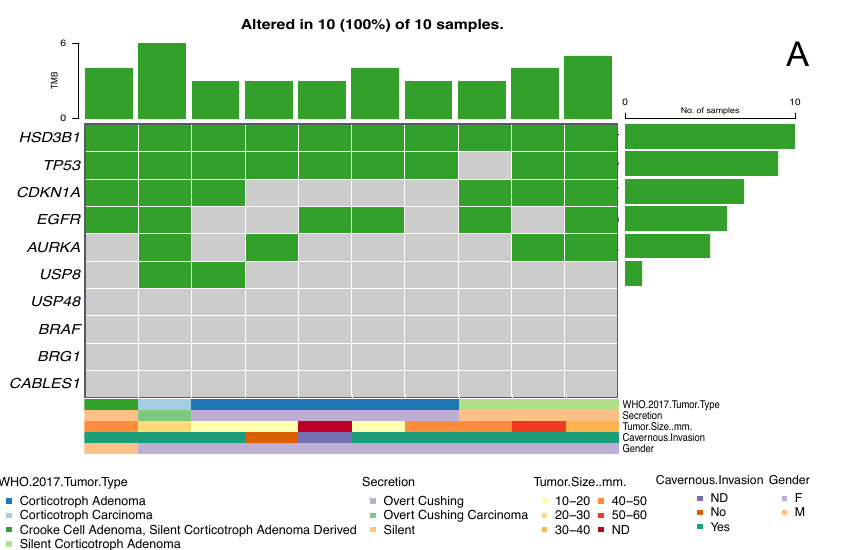
Altered in 10 (100%) of 10 samples.